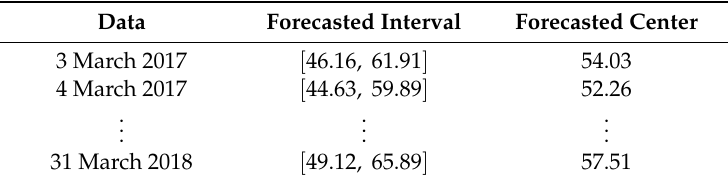
Table 4. Forecasted interval series.